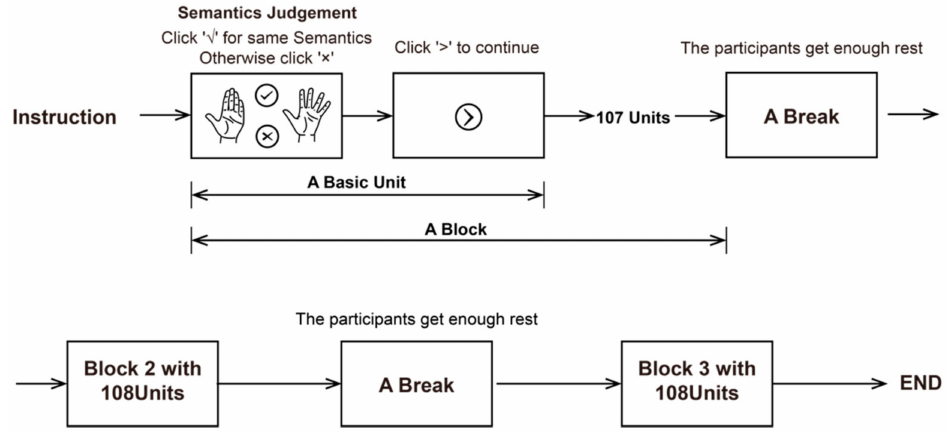
Figure 5. Experimental flowchart of visual perception measurement of semantic differences in motion primitive unit. A total of three blocks are included in the experiment; a block of the experiment consisted of 108 groups of basic units with different stimuli but the same